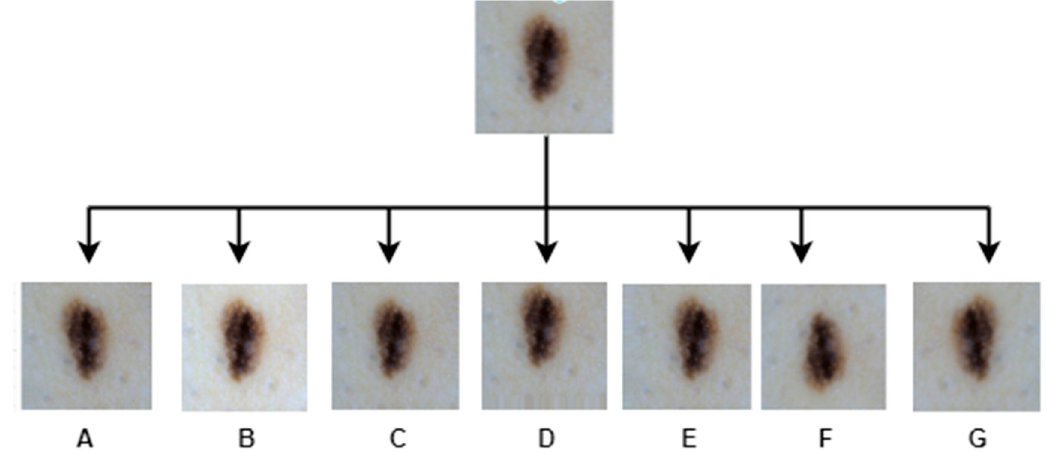
Figure 5. Real image (at the top) and augmented images (A to G).